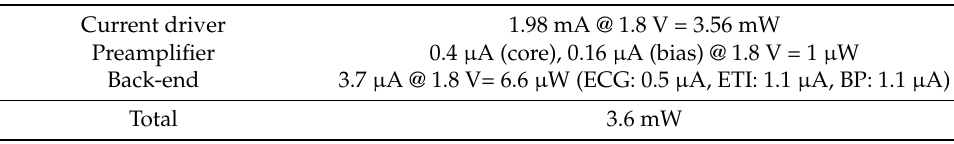
Table 2. Performance Summary.